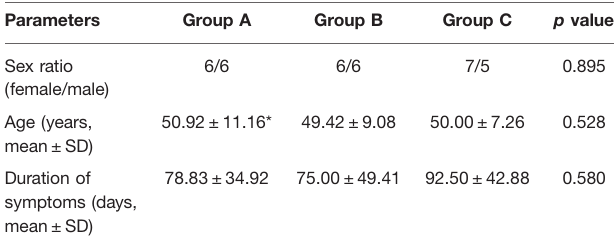
TABLE 1 | Clinical demographic data of three groups that underwent FE-PLIF.